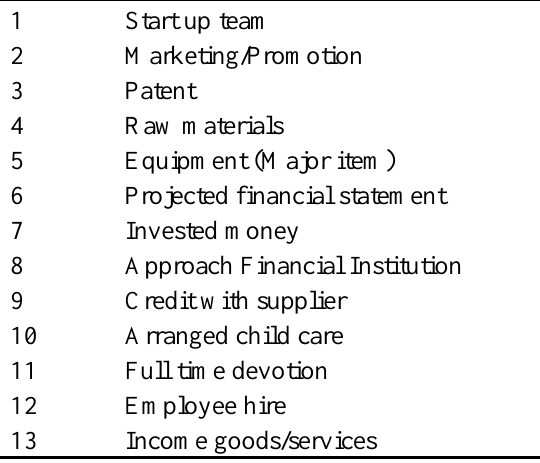
Table 1. Gestations Behaviors counted in control